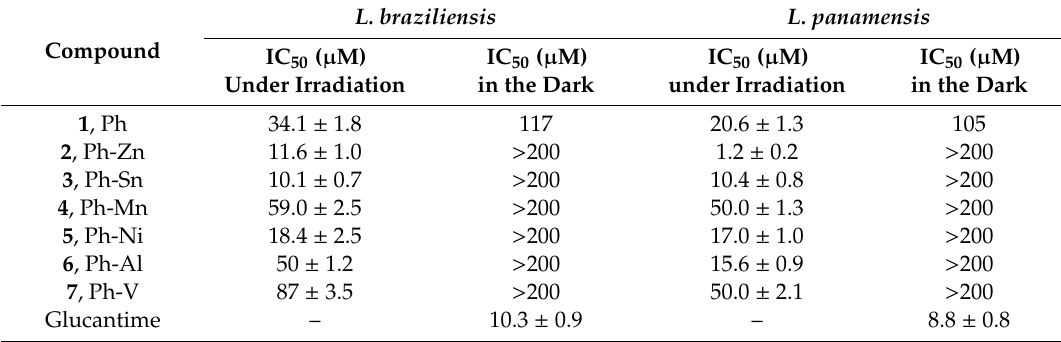
Table 2. IC 50 values for photoinactivation of L. braziliensis and L. panamensis promastigotes in the dark and under visible